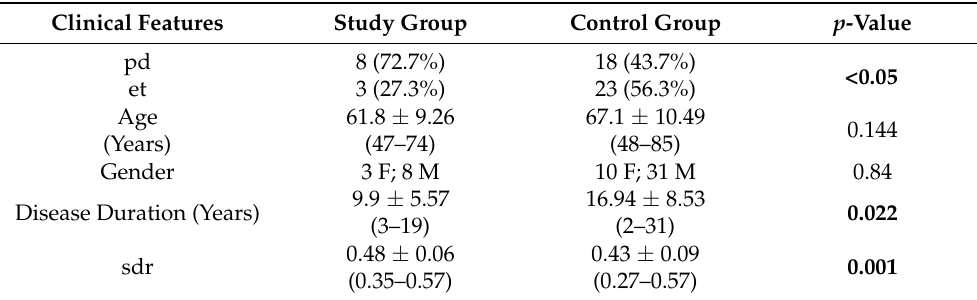
Table 2. Summary of clinical and demographic parameters in the relapse study group and control group. Statistically significant values ( p < 0.05) are in